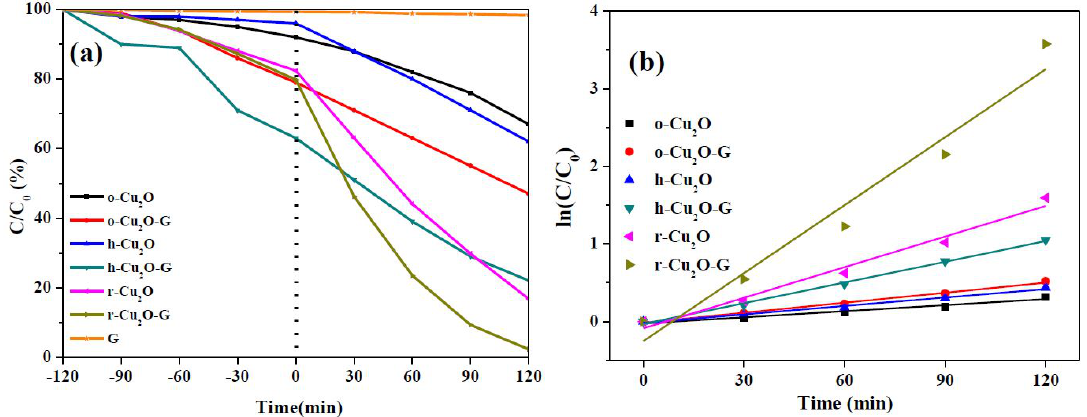
Figure 6. ( a ) Relative concentration of methyl orange (MO) versus time by various photocatalysts under visible light and ( b ) kinetic plots from the data in ( a